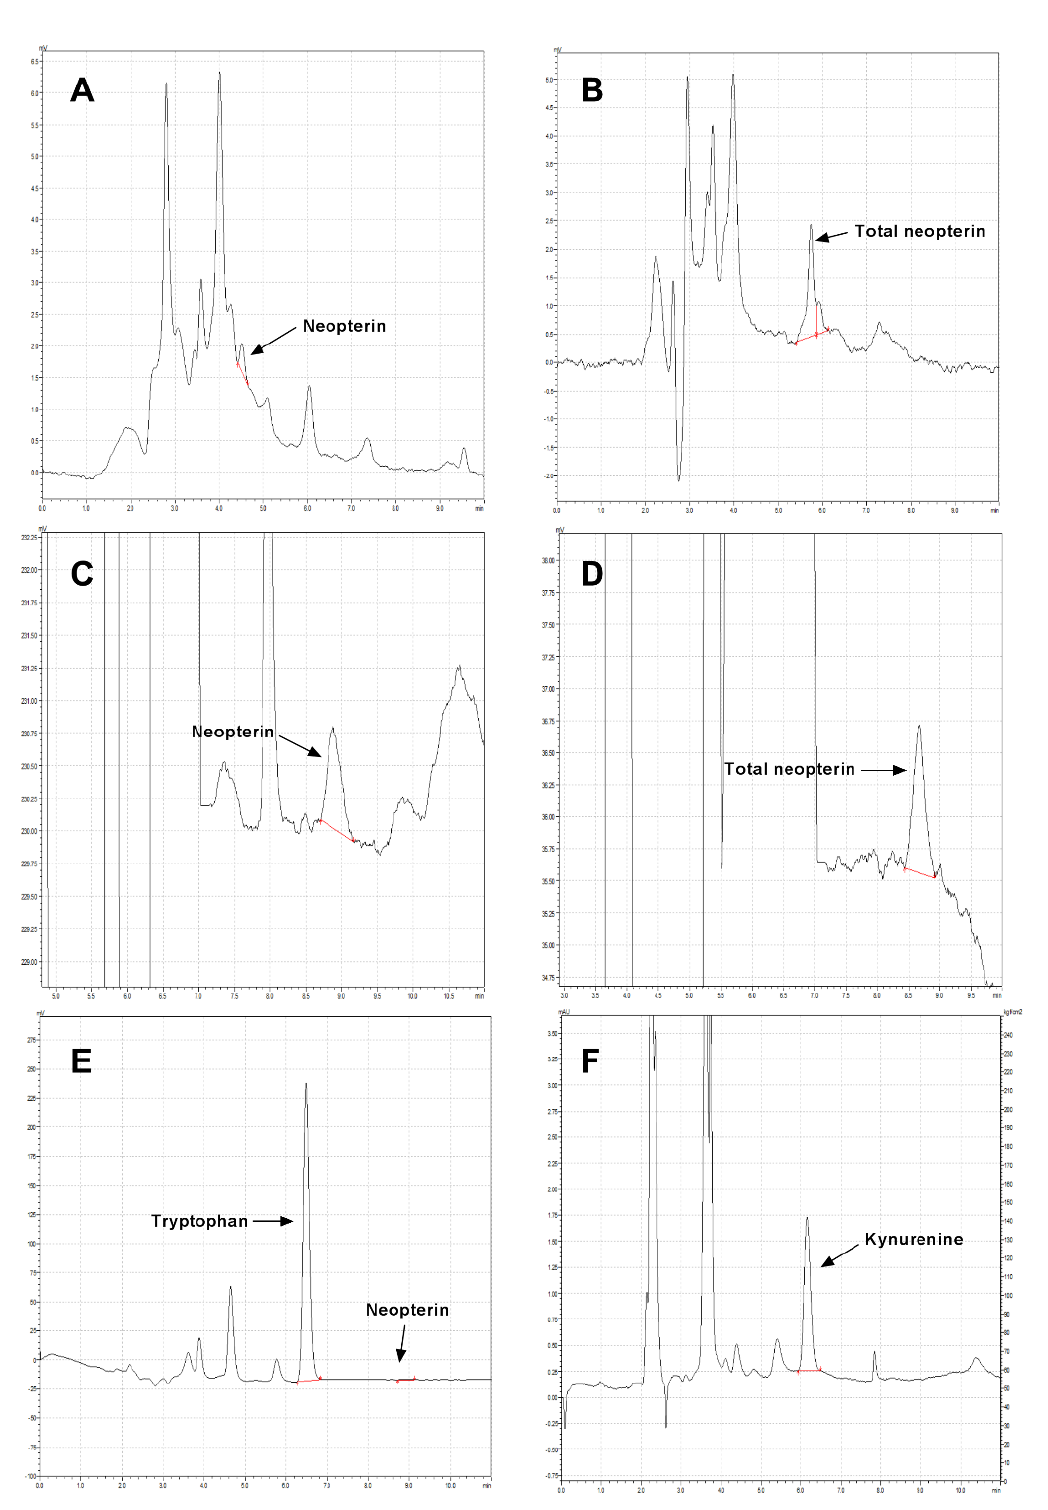
Figure 2: Chromatograms of neopterin (A) and total neopterin (B) measured by SCX-HPLC. Chromatograms of neopterin (C), total neopterin (D), tryptophan (E) and kynurenine (F) measured by amine-HPLC. SCX-HPLC fails to adequately separate neopterin from other compounds for both neopterin and total neopterin samples. Amine-SCX can separate neopterin and total neopterin samples from all other peaks. The tryptophan peak is considerably larger than neopterin. Kynurenine elutes separately to other